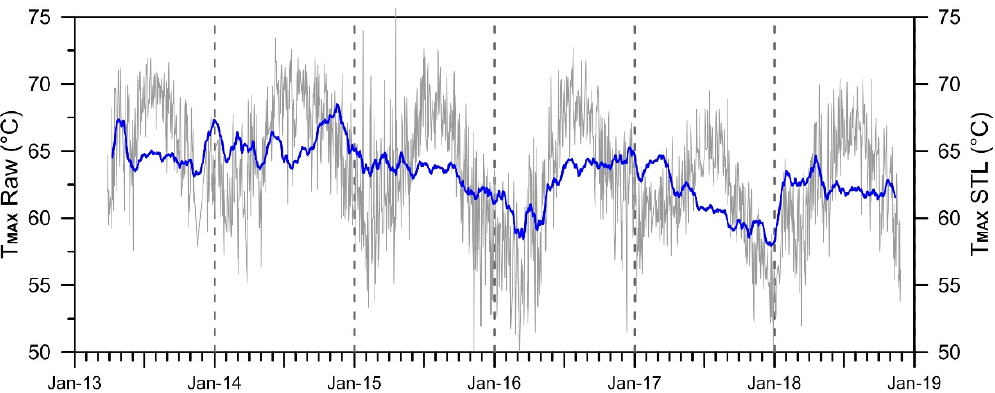
Figure 5. STL decomposition procedure applied to Pisciarelli station: RAW maximum temperature of IR scene (grey color) and de-seasoned maximum temperature of IR scene (blue color).